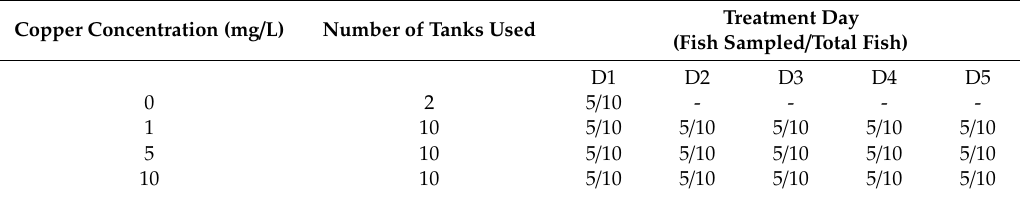
Treatment Day (Fish Sampled / Total Fish) D1 D2 D3 D4 D5